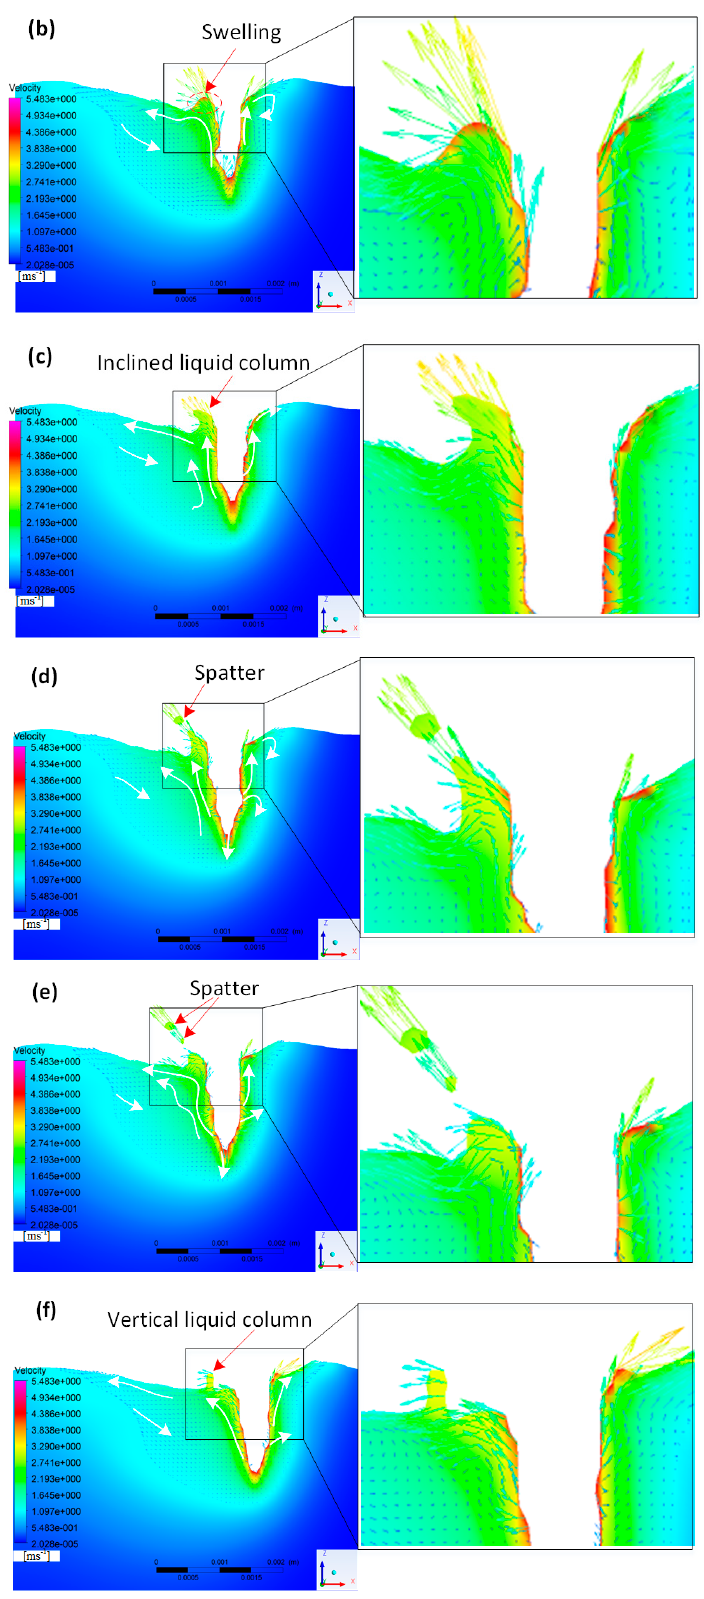
Figure 7. Flow field of molten pool when the welding speed was 6 m/min:( a ) t = 17 ms, ( b ) t = 18.1 ms, ( c ) t = 18.2 ms, ( d ) t = 18.3 ms, ( e ) t = 18.4 ms, ( f ) t = 18.5